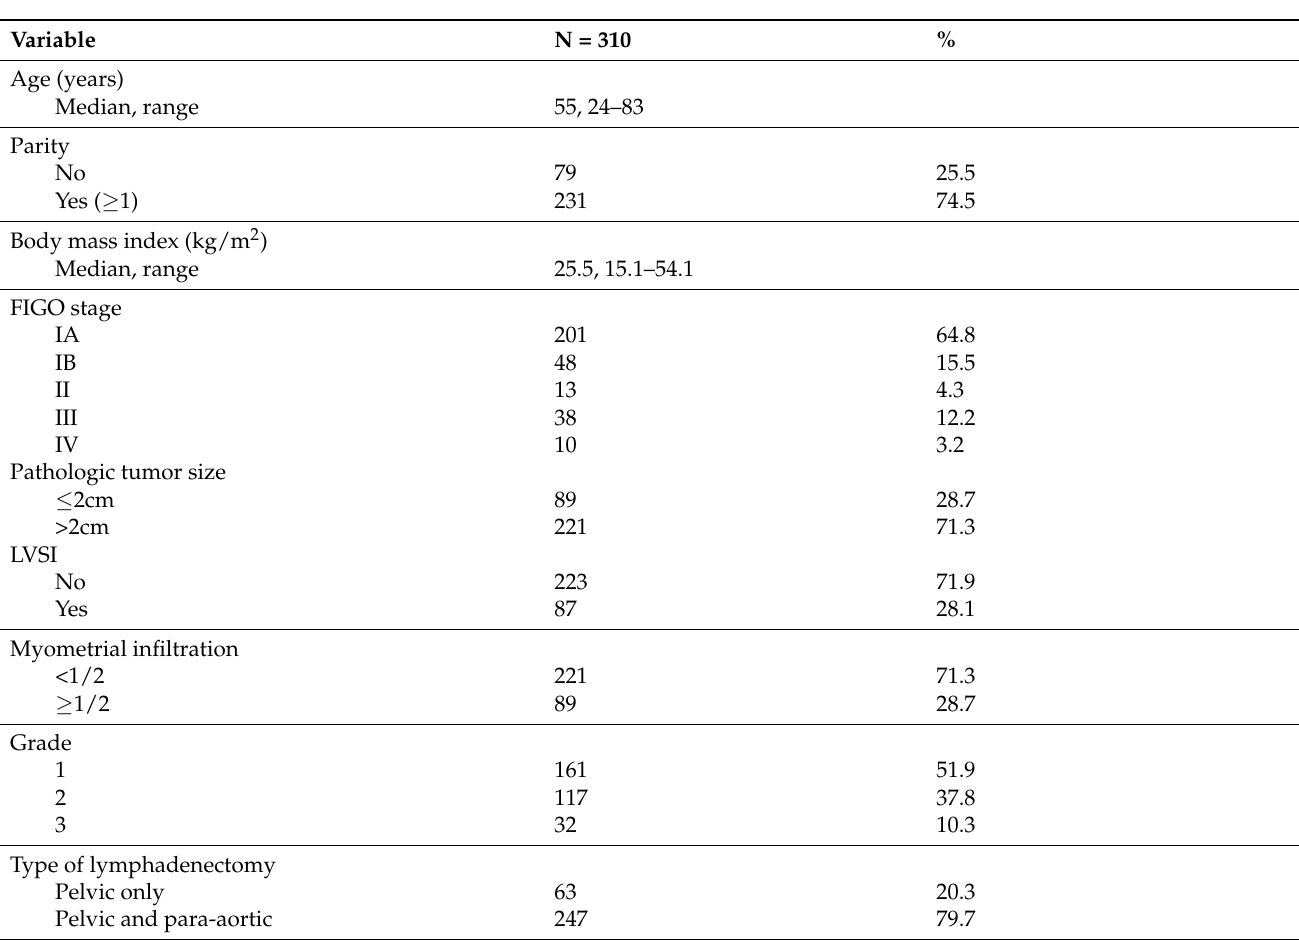
Figure 2. Representative cases of quantitative measurement of immunohistochemical expression of PR in endometrioid-type endometrial cancer. ( A ) Weak expression in 30% of the tumor cells with an H-score of 1 × 30 = 30; ( B ) Strong expression in 95% of the tumor cells with an H-score of 3 × 95 = 285. Table 1. Clinicopathological characteristics of the study population .